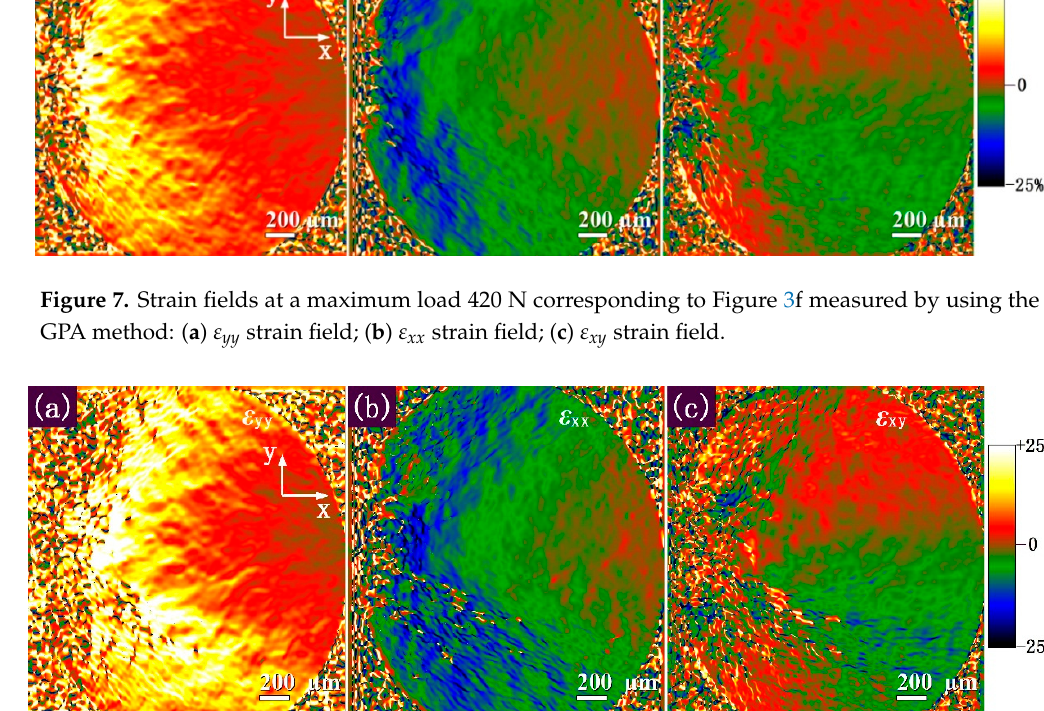
Figure 7. Strain fields at a maximum load 420 N corresponding to Figure 3f measured by using the GPA method: ( a ) ε yy strain field; ( b ) ε xx strain field; ( c ) ε xy strain field.